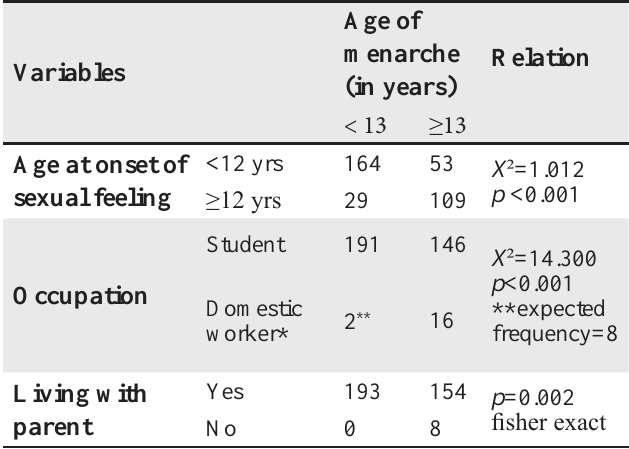
3: Age at menarche and its relation with other factors